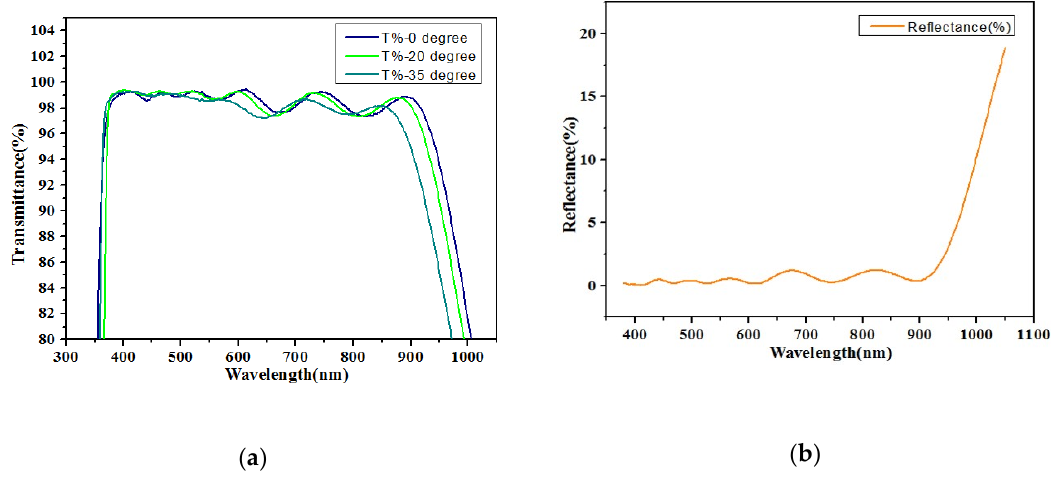
Figure 11. ( a ) Transmittance and ( b ) reflectance spectra of the double coating AR glass.